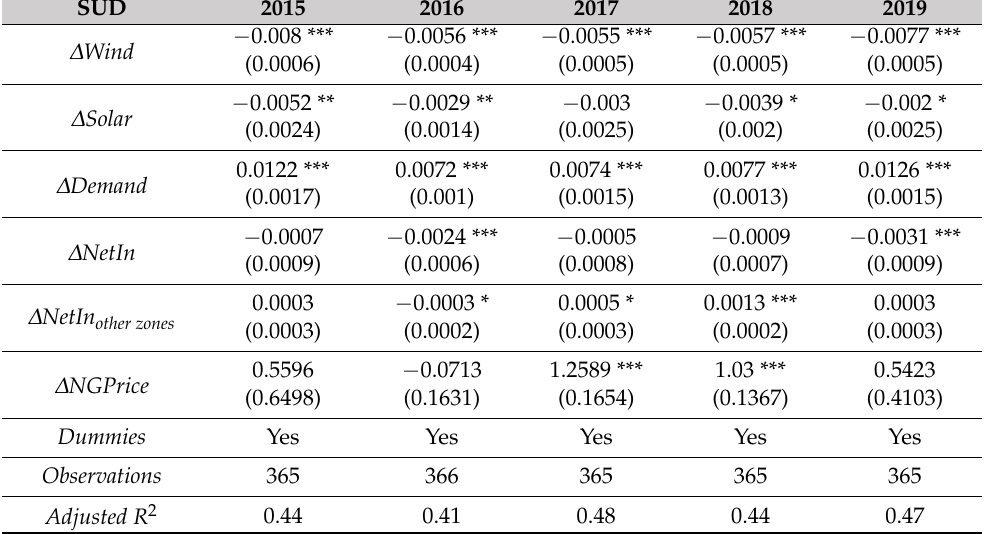
Table A18. OLS estimation of daily changes in electricity prices of SUD; results of Equation